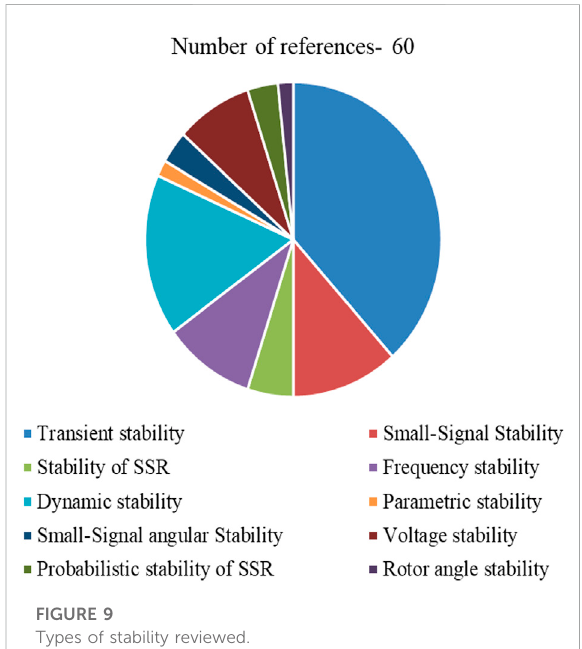
FIGURE 9 Types of stability